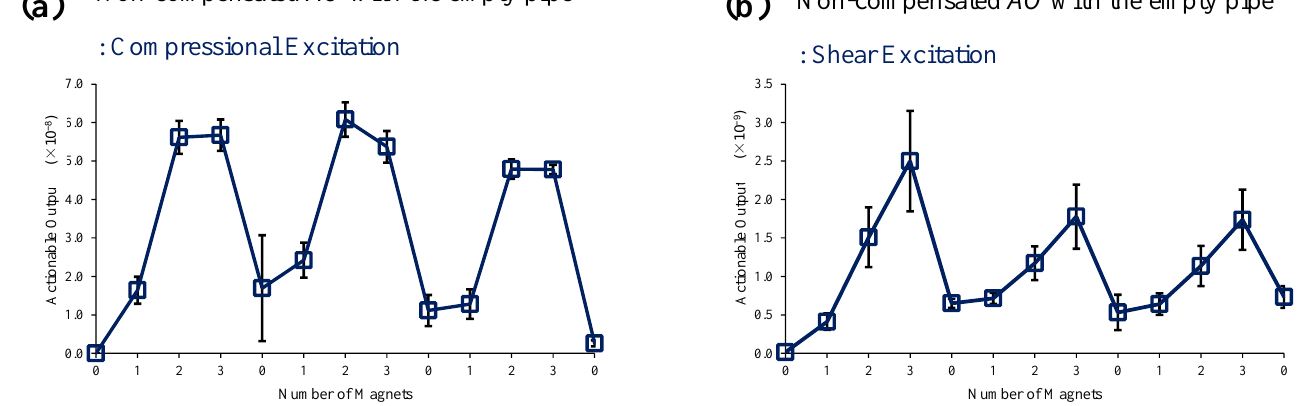
Figure 7. Changes in AO with the different number of magnet perturbations: the empty pipe with ( a ) compressional and ( b ) shear excitations, where no EOC compensation method is applied.